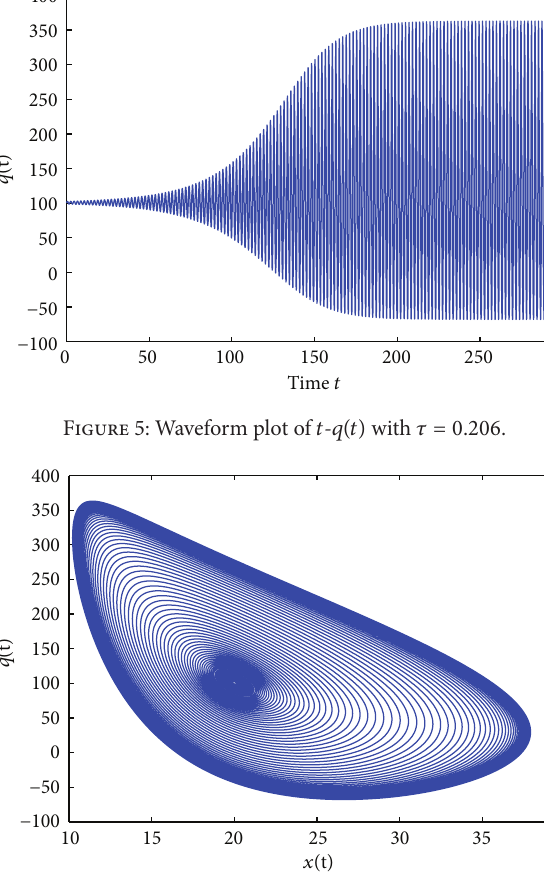
Figure 6: Phase plot for 𝑥(𝑡) - 𝑞(𝑡) with 𝜏 = 0.206